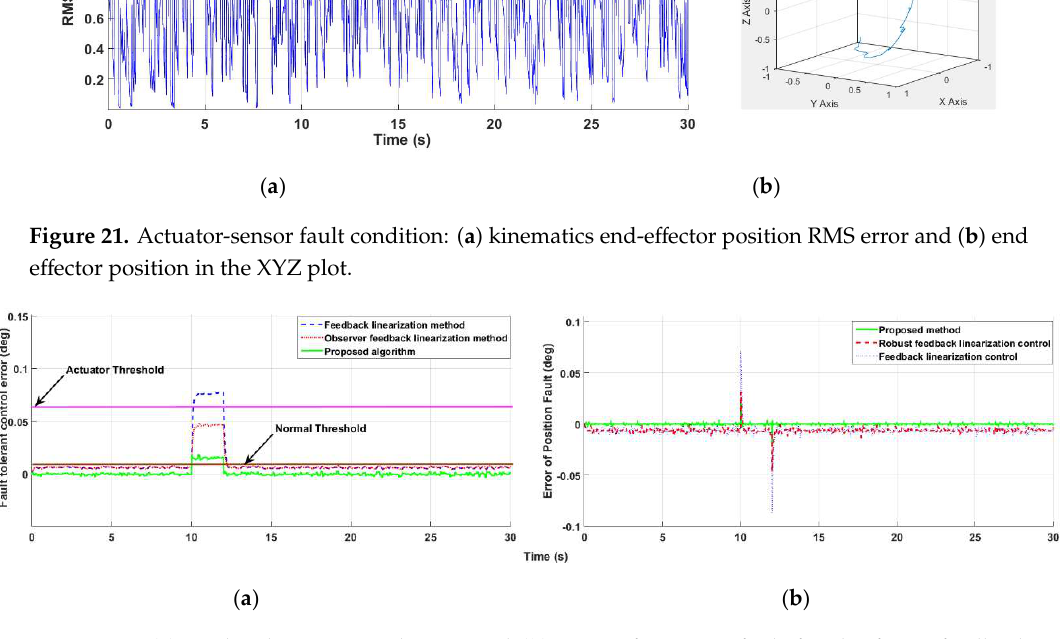
Figure 22. ( a ) Fault-tolerant control error and ( b ) error of position fault for the fuzzy feedback linearization method, observation-based feedback linearization method, and proposed method for the surgical robot for the sinus.